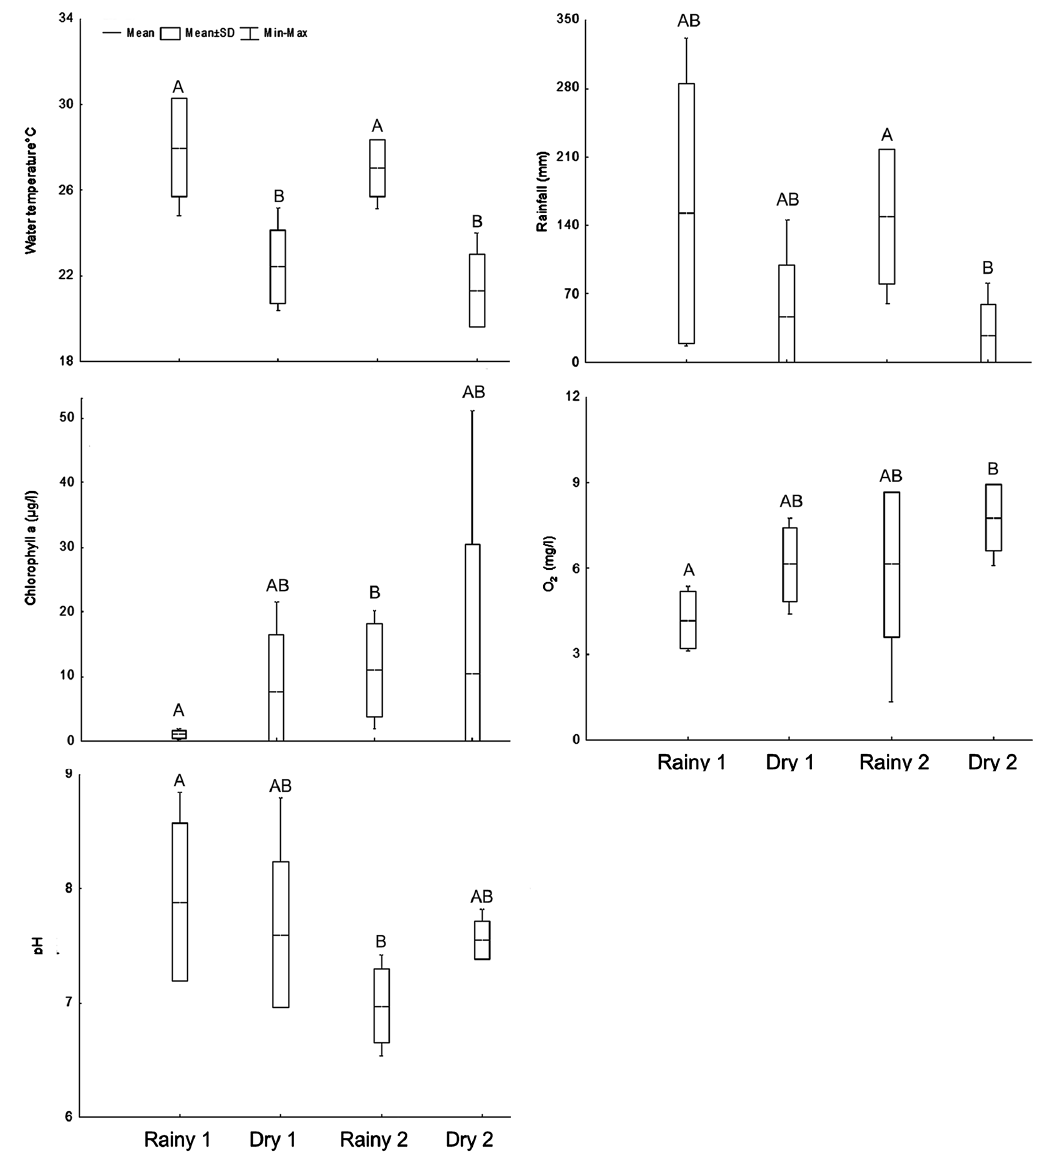
Figure 2 - Mean ± standart deviation, minimum and maximum values of each environmental factor: water temperature, rainfall, chlorophyll-a and O concentration and 2